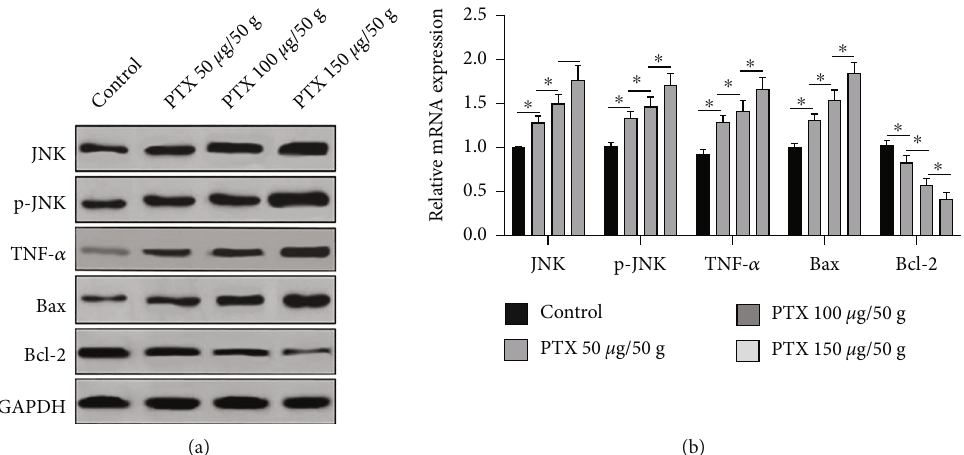
Figure 3: The expression of c-Jun N-terminal kinase (JNK) and tumor necrosis factor (TNF- α ) in myocardial tissue of mice after paclitaxel (PTX) intervention. (a) The expression of JNK and TNF- α protein in myocardial tissue. (b) The expression of JNK and TNF- α mRNA in myocardial tissue. ∗ P < 0 : 05 .